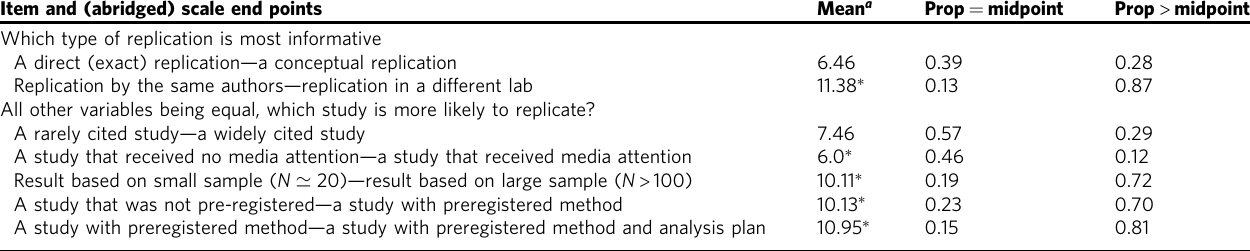
Table 1 Items, scale end points, and results summary of expert